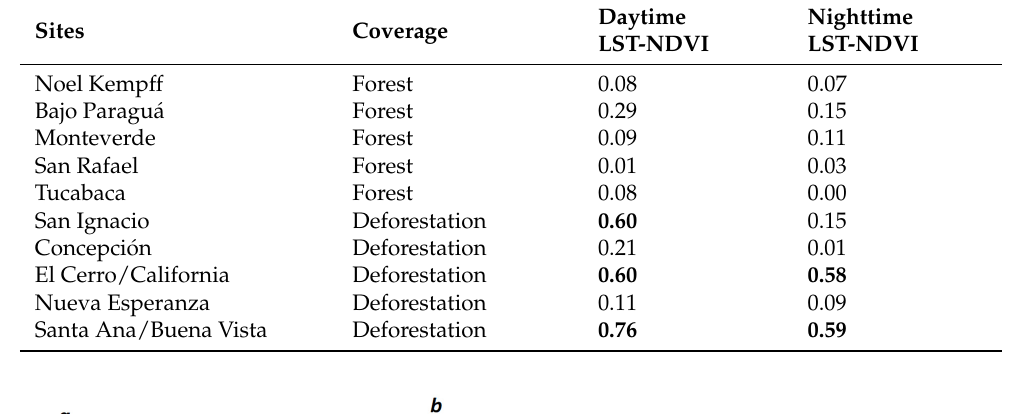
Table 5. Pearson correlation (r) between NDVI values with daytime and nighttime LST for the ten study sites in the Chiquitania region. Higher correlations are highlighted in bold.